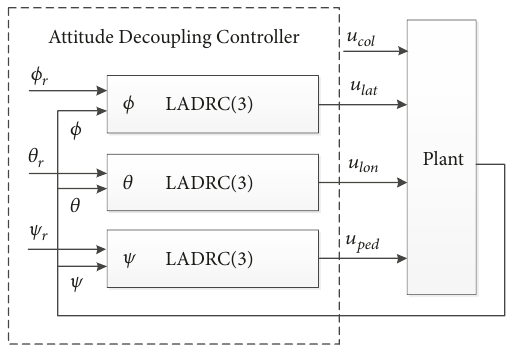
Figure 3: The block diagram of the attitude decoupling controller.